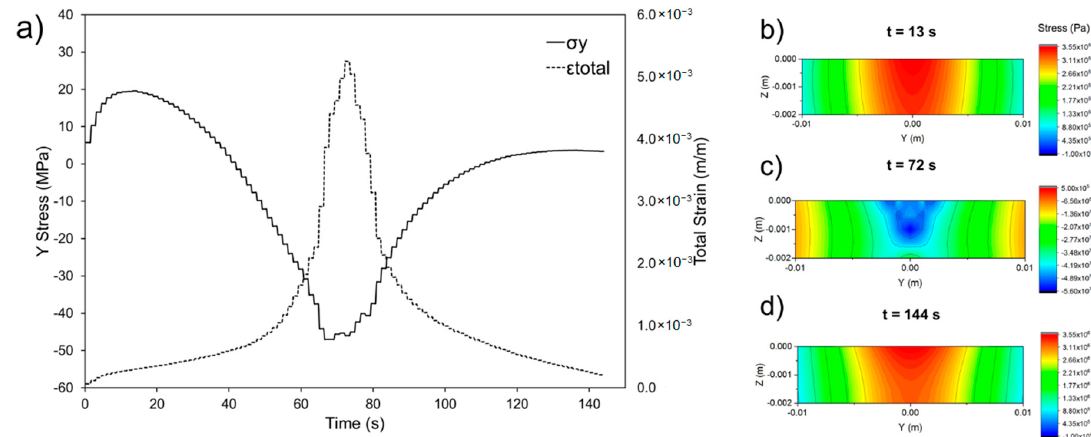
Figure 7. ( a ) Transient thermal stress and strain profiles in test Case A at laser scan speed of 12.5 mm/min: distribution of the stresses within the cross section perpendicular to the laser scan direction at ( b ) 13 s, ( c ) 72 s, and ( d ) 144 s. The tensile compressive stresses are conventionally indicated with the plus and minus signs,